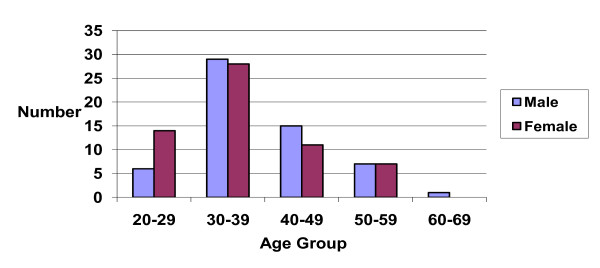
Age distribution.